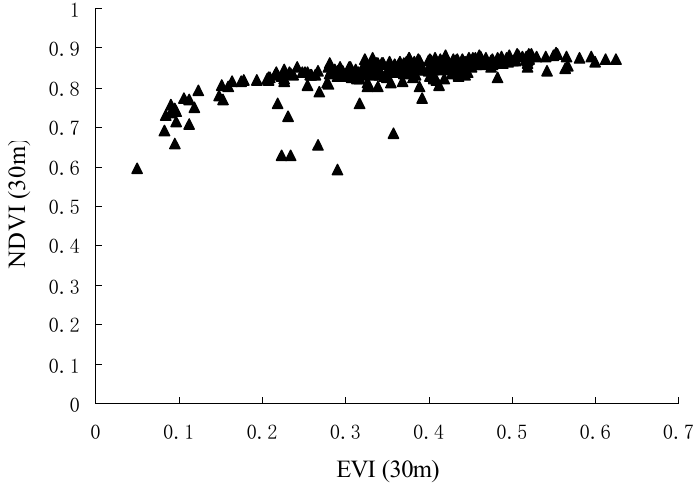
Figure 4. Scatter plot of EVI and NDVI after the image was resampled to